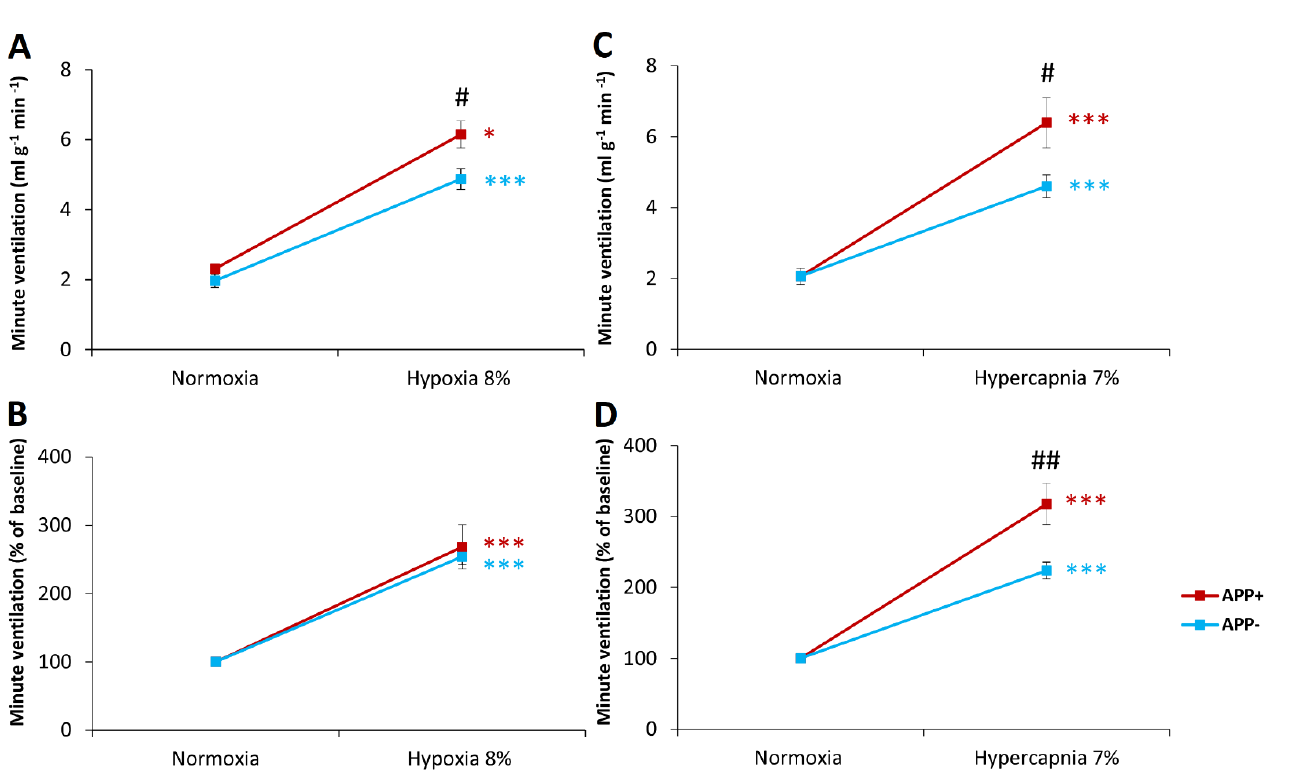
Figure 1. Minute ventilation (V E ) during air breathing (normoxia) and ventilatory response to hypoxia and hypercapnia in APP+ (red line) and APP− mice (blue line) ( A , B ). Minute ventilation reactivity to hypoxia and hypercapnia expressed as a percentage of baseline (normoxia) values ( B , D ). Note the lack of difference in hypoxia reactivity in the two groups of mice ( B ) and significant increase in respiratory response and reactivity to hypercapnia in APP+ mice ( C , D ). The data are presented as mean ± SEM; * p < 0.05. *** p < 0.001 vs. normoxia value. # p < 0.05, ## p < 0.01 vs. APP− group (n = 6 for APP+ and APP− ).